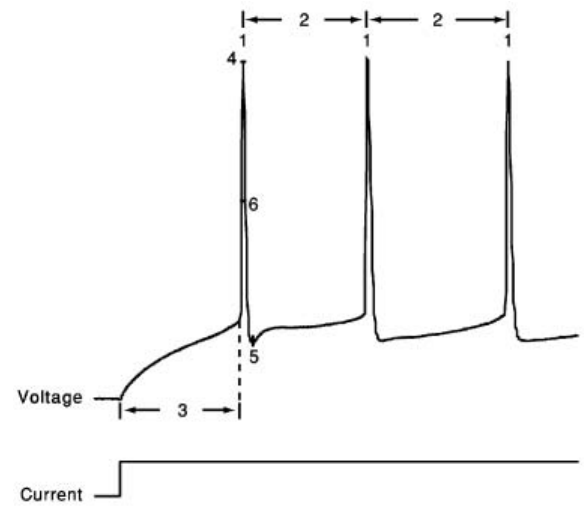
Figure 2. Feature extraction . Voltage response (top) to a step depolarizing current (bottom) of the first 200ms following stimulus onset of the trace dis- played in Figure 1A . Extraction of the six features is schematically portrayed. 1 , spike rate; 2 , accommodation index (Equation 3); 3 , latency to first spike; 4 , AP overshoot; 5 , After hyperpolarization depth; 6 , AP width. For values of the different features in the case of the two electrical classes depicted in Figure 1 , see Table 1